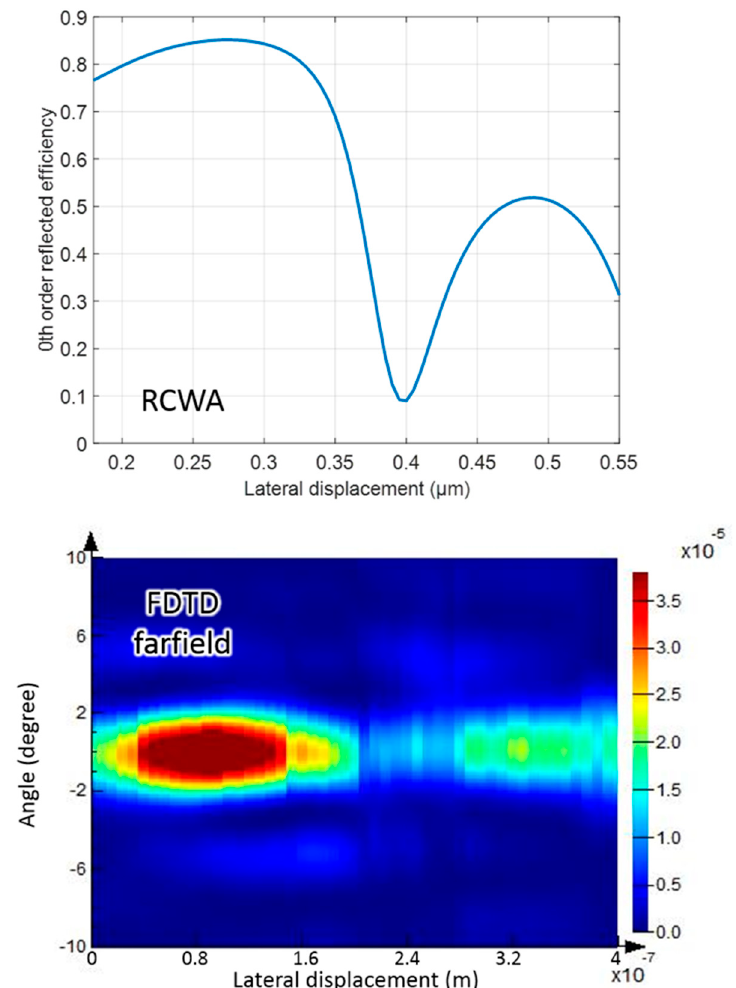
Figure 5. Comparison of the rigorous coupled wavelength analysis (RCWA) simulation result with the finite-different-time-domain (FDTD) simulation result for the identical optimal settings. The far field electric intensity of the FDTD result was recorded from +10° to − 10°.